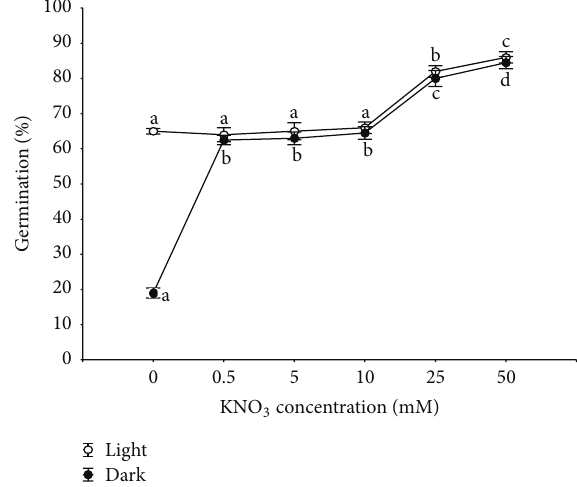
Figure 6: Effect of KNO 3 − concentration on cumulative germina- tion of R. confertus seeds at 22 ∘ C for 20 days. Means ( 𝑛 = 4 ) with the same letter do not differ among different KNO 3 concentrations with the same light conditions (ANOVA Tukey’s test, 𝑃 > 0.05 ). Error bars indicating standard deviations are shown only where it was larger than the point size.